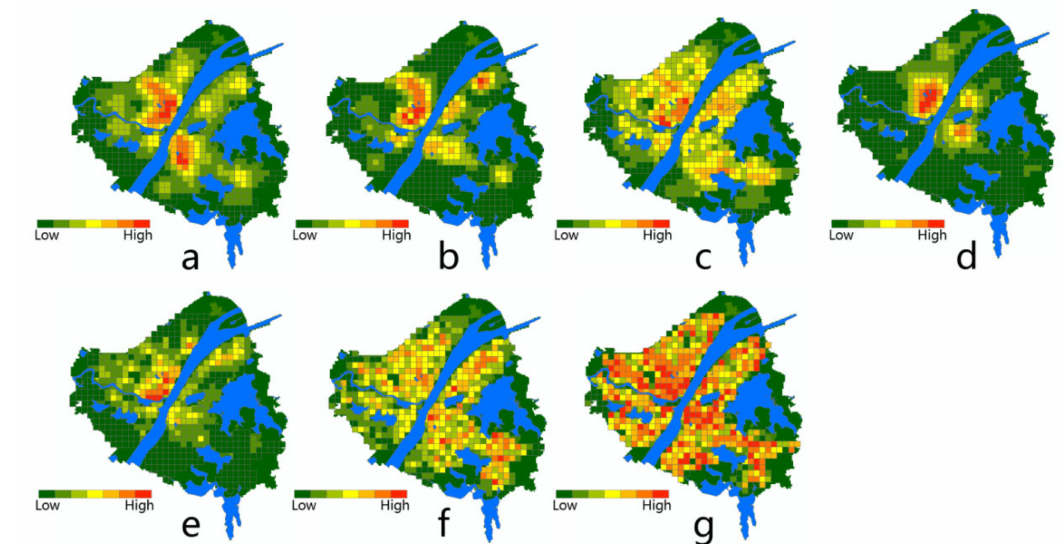
Figure 5. Kernel density of the selected urban factors, ( a ) commercial; ( b ) hospital; ( c ) FAR; ( d ) subway station; ( e ) community aging ratio; ( f ) road density; ( g ) land-use